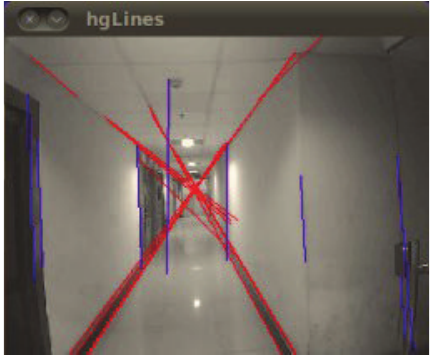
Figure 5: Straight lines